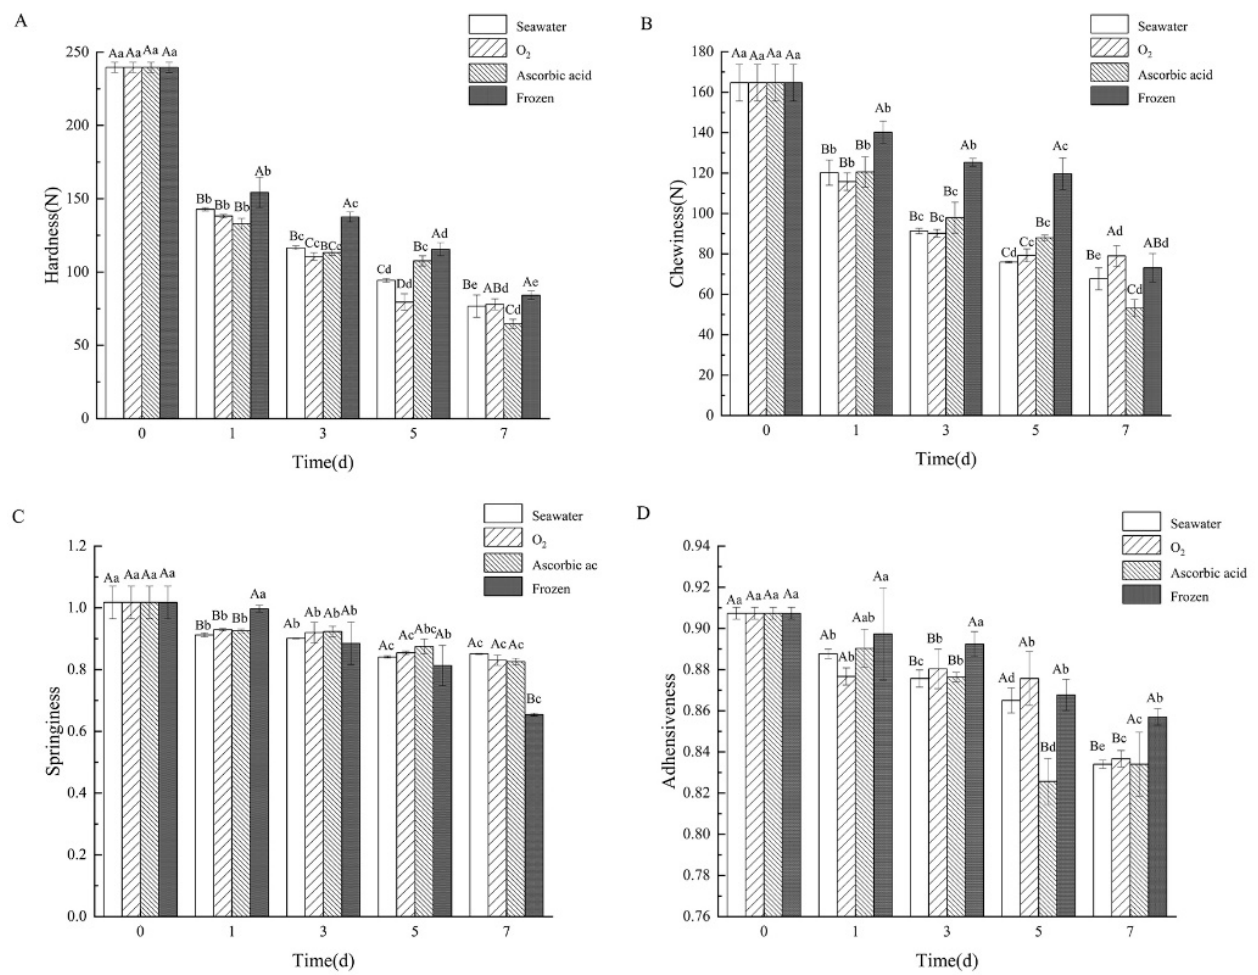
Figure 4. Changes of the ( A ) hardness, ( B ) chewiness, ( C ) springiness, and ( D ) adhesiveness of boiled sea cucumber body wall (SCBW) in different treatment groups during storage. Dates are presented as mean ± SD ( n = 6). Different capital letters indicate significant differences in the average between groups. Different lowercase letters indicate significant differences in the average value within each group ( p <